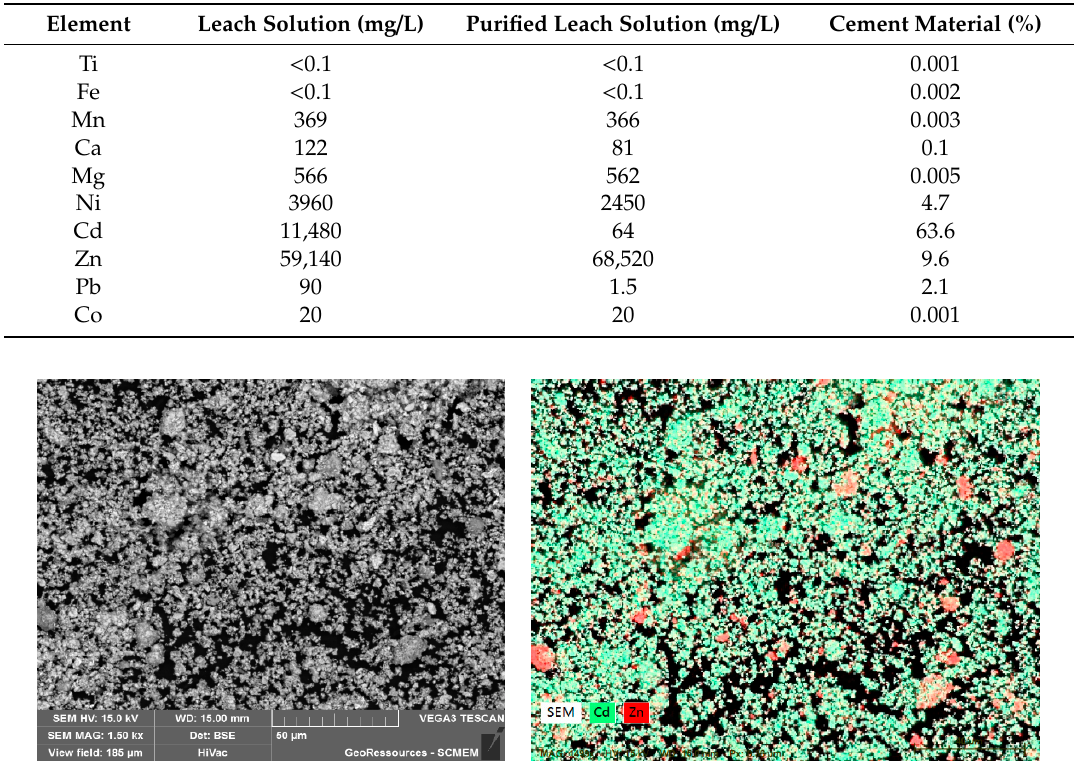
Figure 5. SEM image with over laid EDS mapping of cement material obtained after cementation of cadmium from leach solution. Table 3. Chemical composition of leach solution, purified leach solution and cement material.